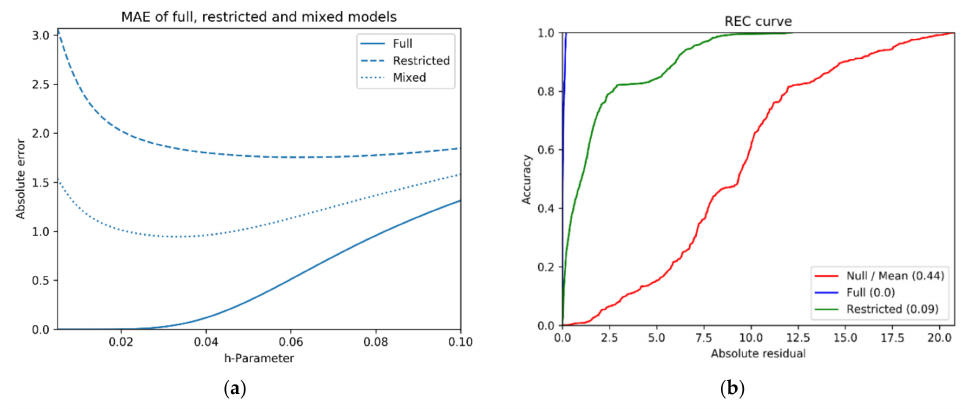
Figure 1. Effect of overfitting and determination of optimum level for parameter h: ( a ) Typical behavior of MAE (Mean Absolute Error) for the full, restricted and mixed models in terms of h; ( b ) Typical REC curve for the null, full and restricted